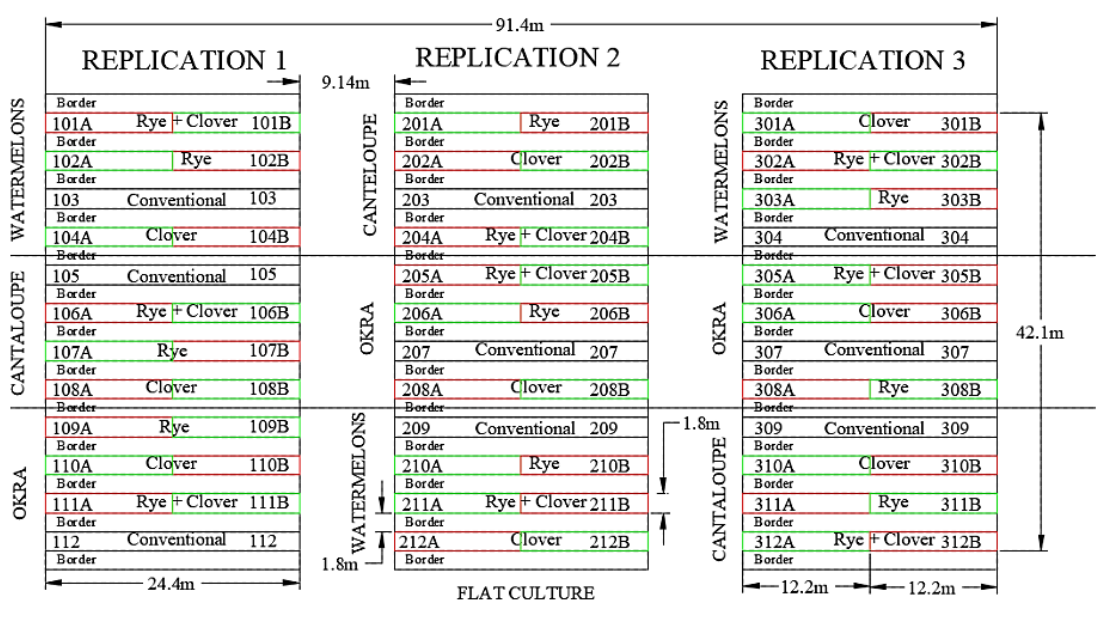
Figure 1. Experiment layout for the on-farm organic no-till experiment.